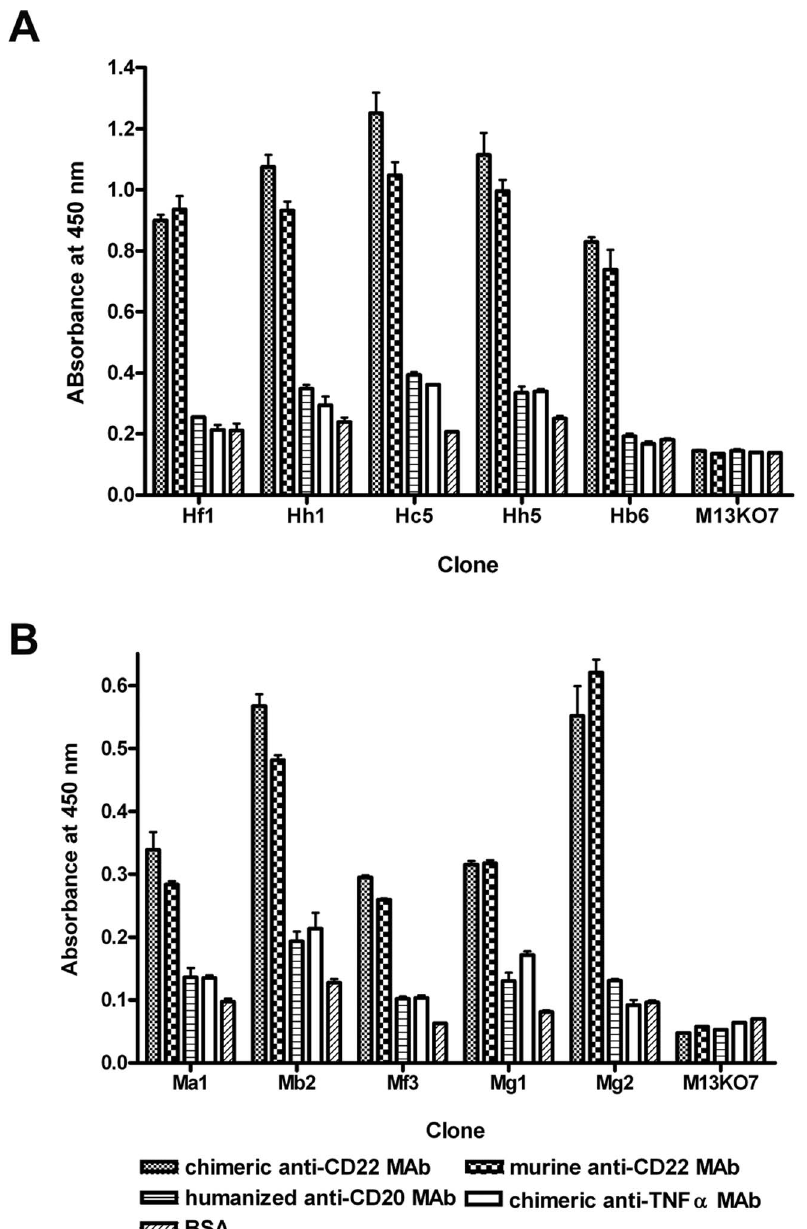
Figure 3. Binding specificity of selected scFv phage clones. Binding specificity of selected phage clones derived from panning against chimeric (A) or murine (B) anti-CD22 MAb were examined by phageELISA as described in Methods. Freshly prepared phages were incubated with 0.1 m g/well of chimeric anti-CD22 MAb (column bars with diffuse dots pattern), murine anti-CD22 MAb (column bars with chessboard pattern), humanized anti-CD20 MAb (column bars with horizontal lines pattern), chimeric anti-TNF a MAb (open column bars), or BSA (column bars with diagonal lines pattern) for 1 h, and bound phages were detected with HRP-conjugated anti-M13. Results are expressed as means 6 SEM of duplicates. Data shown is a representative of three separate experiments with similar